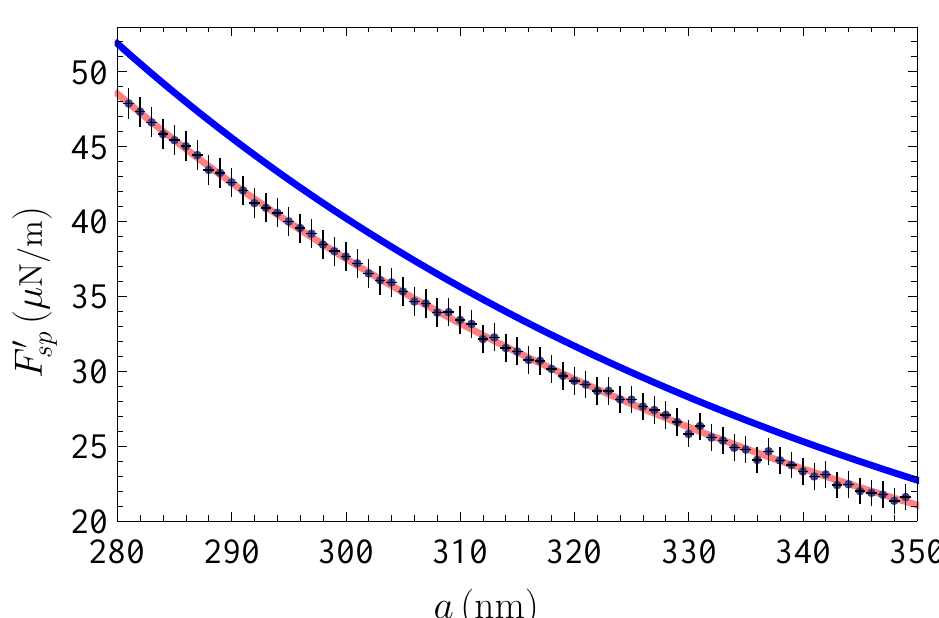
Figure 3. The gradients of the Casimir force between an Ni-coated sphere and an Ni-coated plate measured using a dynamic atomic force microscope [25] (crosses) compared with theoretical predic- tions of Lifshitz theory using the Drude and plasma extrapolations of the optical data of Ni (blue and red bands,